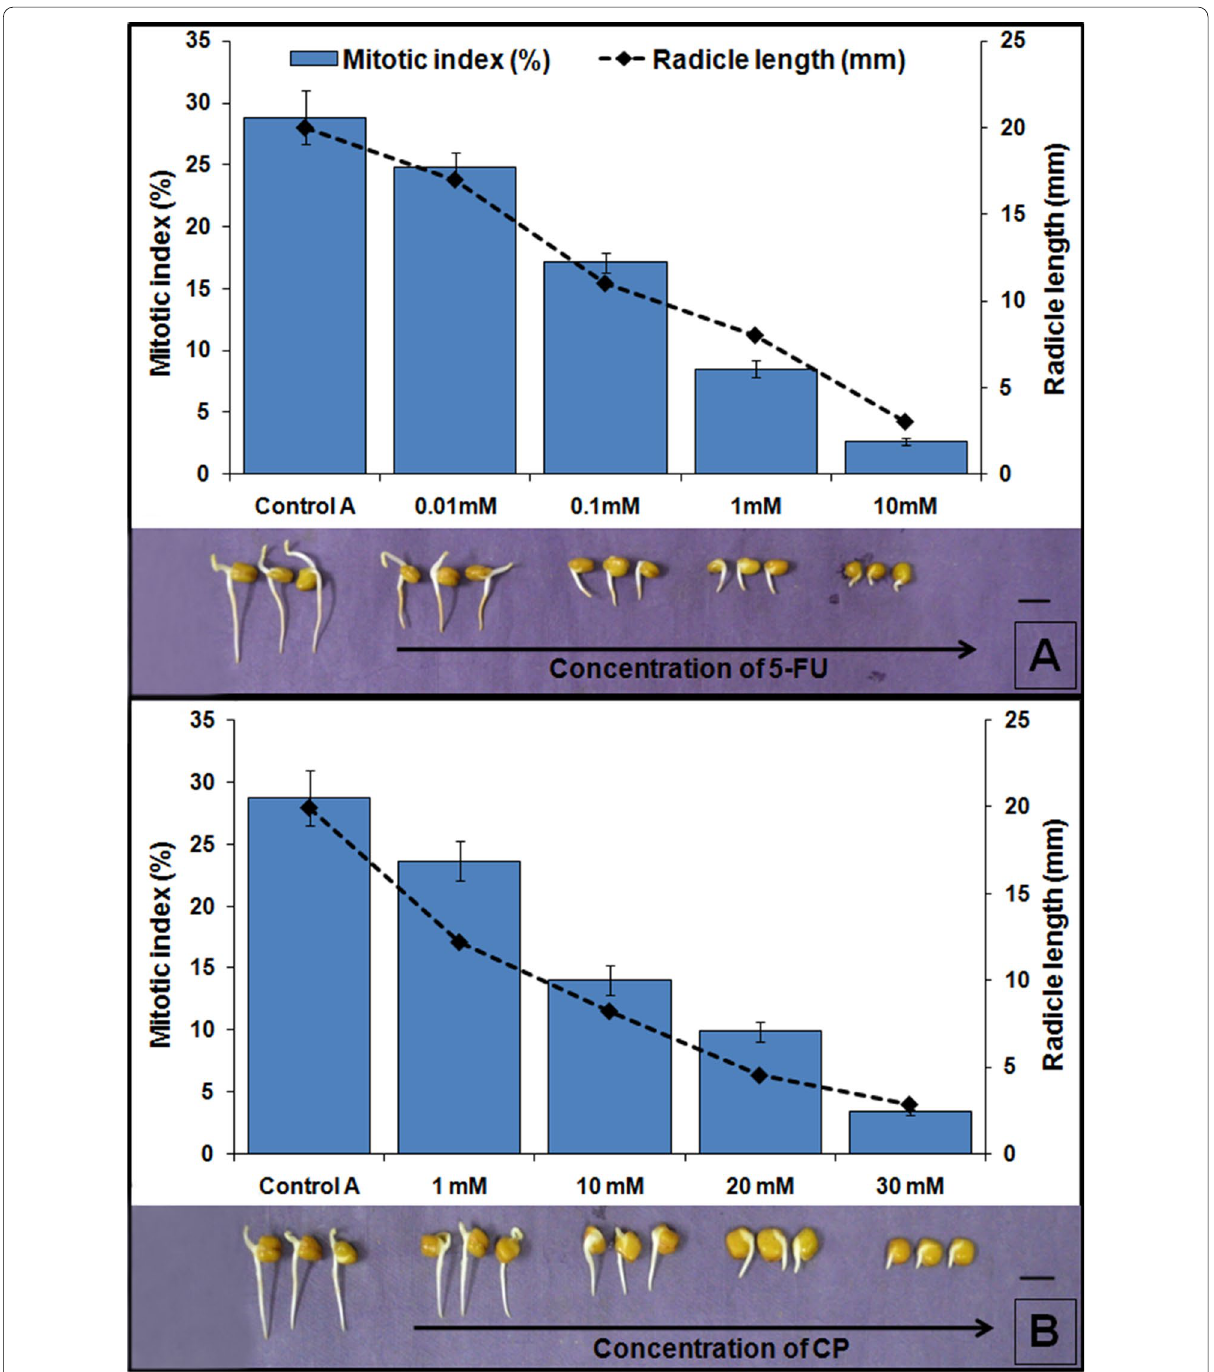
Fig. 1 Effect of different concentrations of ( A ) 5-Fluorouracil and ( B ) Cyclophosphamide on radicle length and mitotic index of Lathyrus sativus . Scale bar 10 =